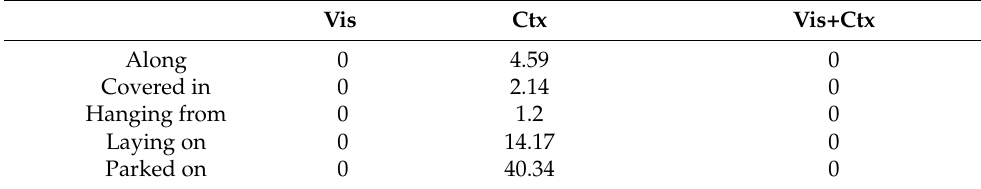
Table 10. R@100 values of each model for selected relationship categories in the SGDet task.